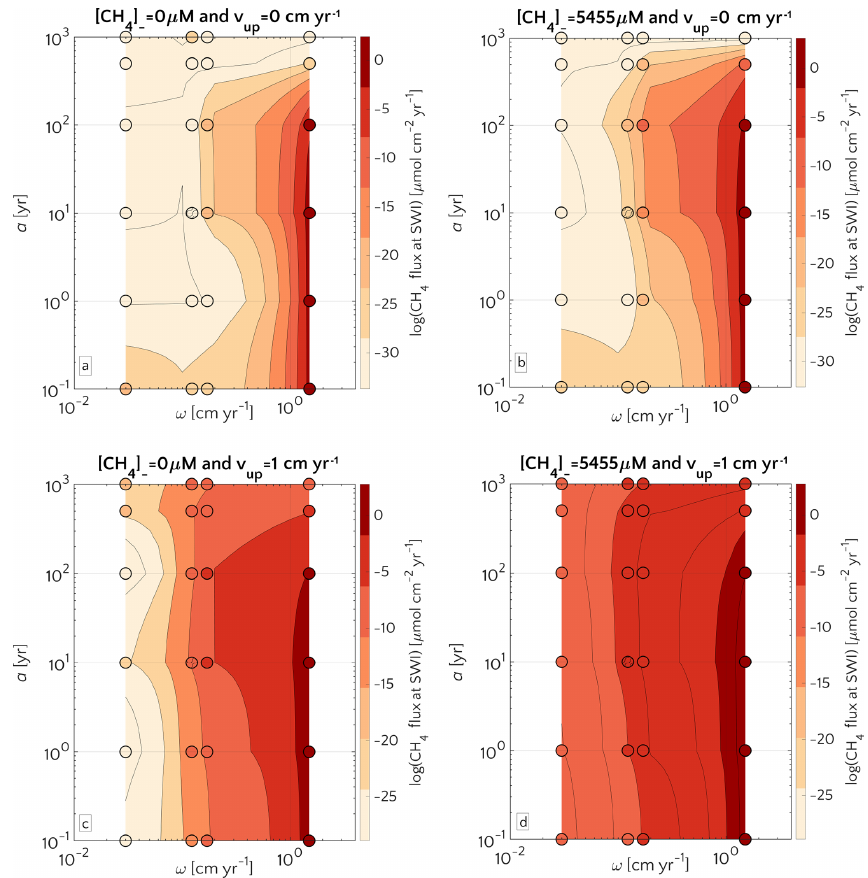
Figure 5. Flux of methane at the SWI as dependent on a and ω . For [ CH 4 ] − = 0mM (a, c) and [ CH 4 ] − = 5 . 455mM (b, d) , and passive (a, b) and active (c, d) case. The circle with pattern corresponds to the baseline